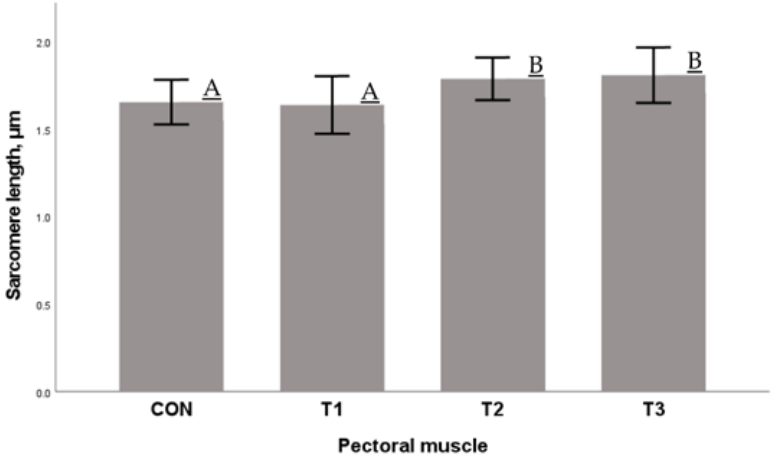
Figure 3. Length of sarcomeres in the pectoral muscle of cockerels. Data are given as mean ± SEM (n = 10); A, B —values denoted with various letters differ significantly at p ≤ 0.01; CON—control group; T1—diet with upper dose of inorganic Se (0.5 mg/kg feed); T2—diet with upper dose of Se in the organic form (0.5 mg/kg feed); T3—diet with upper dose of Se in the form of nanoparticle s (0.5 mg/kg